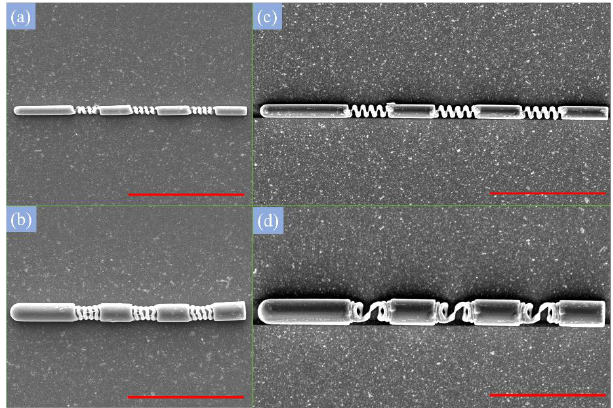
Figure A1. Scanning electron microscopy (SEM) images of the microswimmers with the diameter and the length of: ( a ) 4 and 100 µ m; ( b ) 8 and 100 µ m; ( c ) 6 and 150 µ m; and ( d ) 12 and 150 µ m. The scale bar is 50 µ m for all